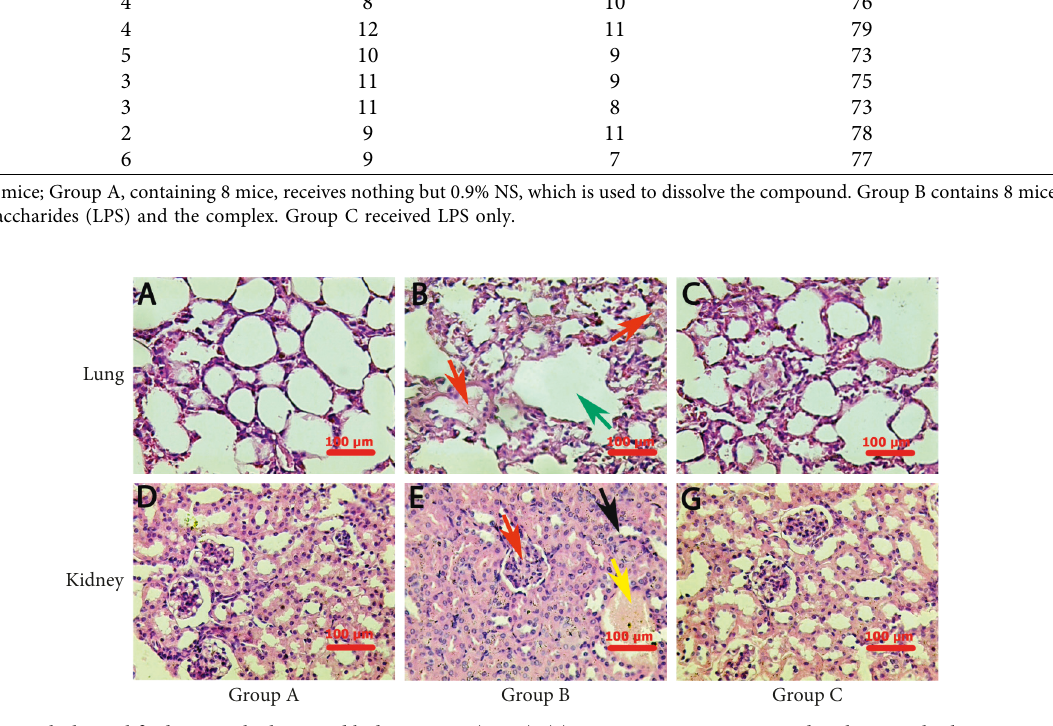
Figure 3: Histopathological findings in the lung and kidney tissue (H&E). (a) Lung tissue section treated with normal saline 0.9% as control showed normal histology of the lung consisting of alveoli surrounded by normal alveolar septae and no inflammatory cell infiltration. (b) Lung section of LPS-injected group C showed alveolar hemorrhage and pretentious material (red arrow), interstitial inflammatory cell infiltration, and diffuse alveolar damage (green arrow) (score 3 tissue damage). (c) Lung tissue section of LPS-injected and quercetin complex-treated group B showed reduced inflammatory cell infiltration in some areas and focal dispersed destruction of alveolar (score 1 tissue damage). (d) The tissue section of the kidney treated with normal saline 0.9% of the control group (group A) showed normal histological appearance, consisting of glomeruli, proximal and distal convoluted tubules, and no interstitial inflammatory cell infiltration. (e) Renal section of LPS-injected group C showed dilated glomerular capillaries (red arrow), congested blood vessels, damage of renal tubules with the presence of hyaline cast inside renal tubules (yellow arrow), and focal inflammatory cell infiltration (black arrow) (score 4 tissue damage). (f) Kidney tissue section of LPS-injected and quercetin complex-treated group B showed only mild degenerative changes of epithelial renal tubules (score 1 tissue